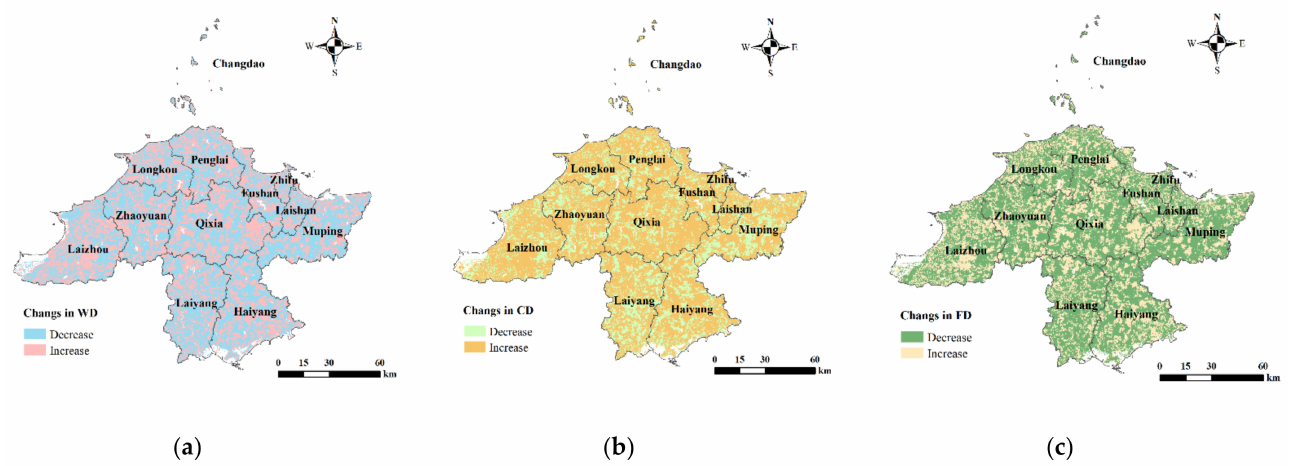
Figure 10. ( a ) Changes in Water demand in Yantai from 2009 to 2015; ( b ) changes in Carbon demand in Yantai from 2009 to 2015; ( c ) changes in Food demand in Yantai from 2009 to 2015.